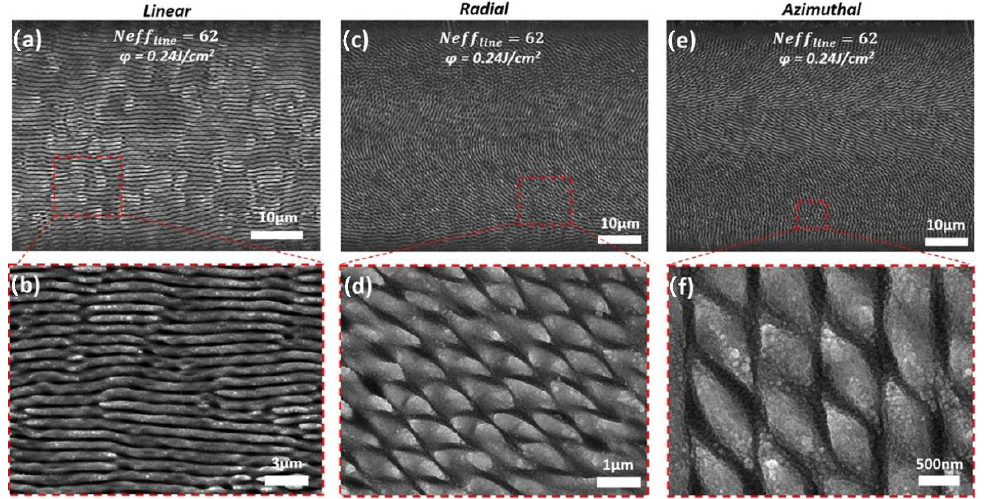
Figure 5. Ref. [57] The SEM images depicting line scans produced by linearly ( a , b ), radially ( c , d ), and azimuthally polarized ( e , f ) beams, respectively, at v = 0.5 mm/s, and F = 0.24 J/cm 2 . The images ( b , d , f ) are higher magnifications of an area inside the red dashed squares and reveal the biomimetic shark skin-like morphology of the processed areas.